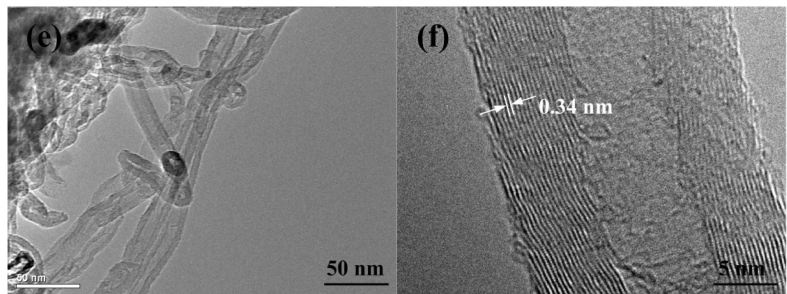
Figure 1. Morphologies of the as-received powders. FESEM micrographs of the 2014 aluminum alloy powders with different particle size: ( a ) 20 µ m; ( b ) 9 µ m; ( c ) 5 µ m; Micrographs of carbon nanotubes: ( d ) FESEM; ( e ) TEM; ( f )